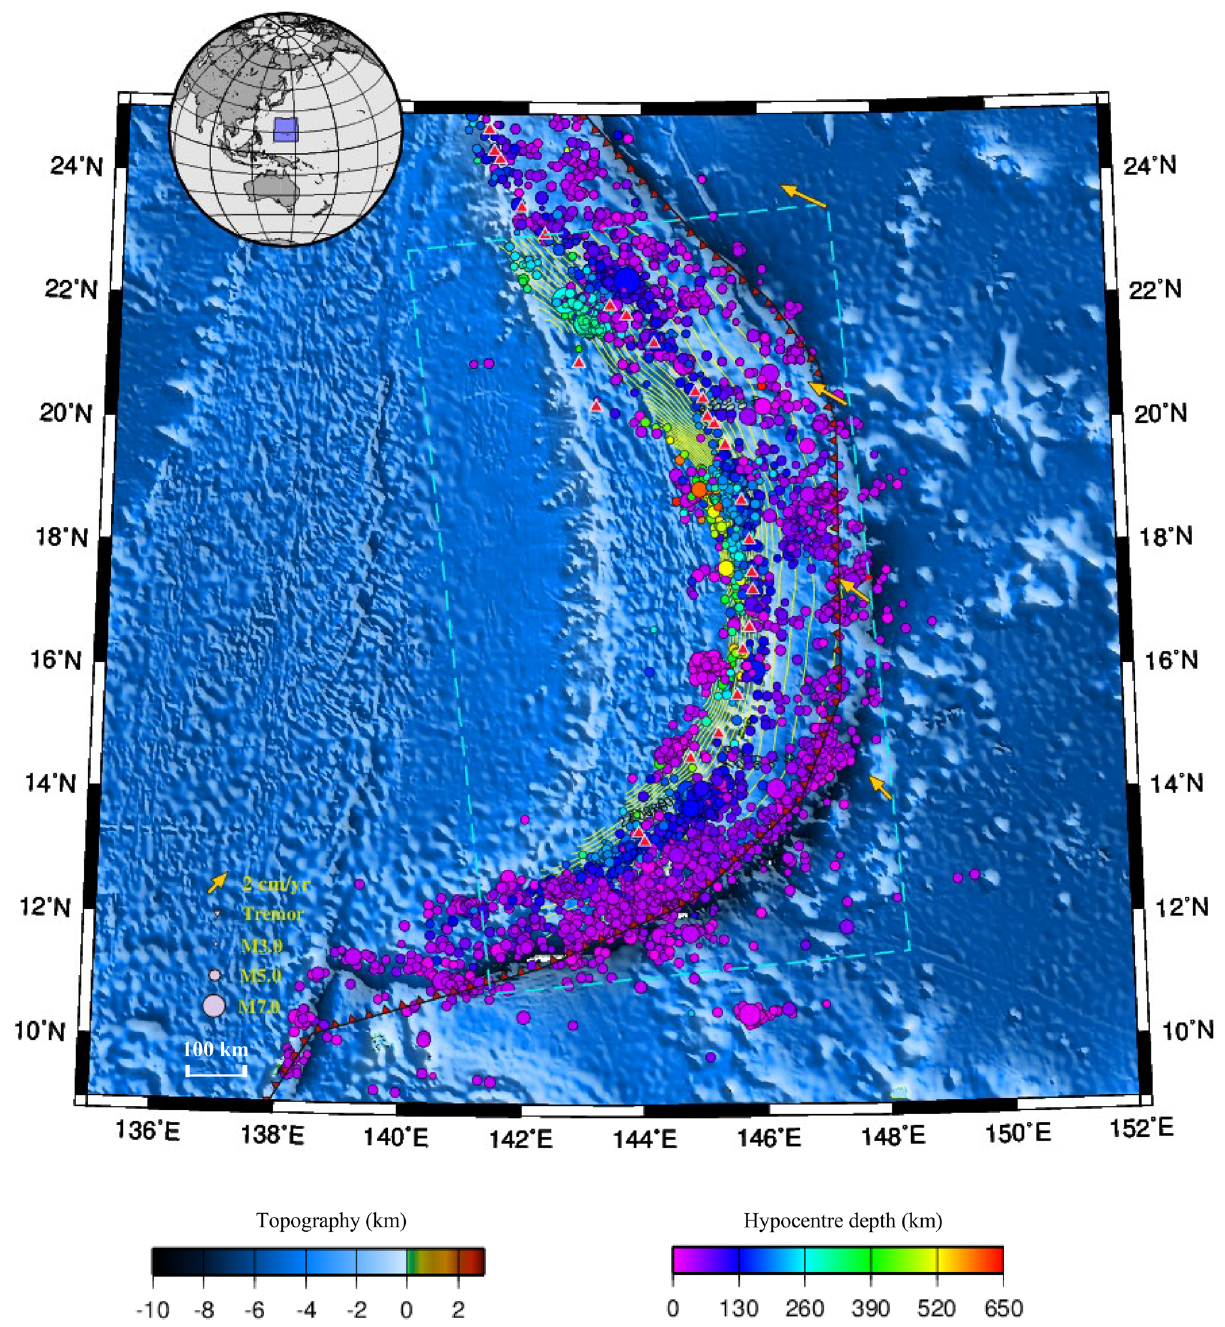
Figure 1. Tectonic map of the Marianas. Background colors indicate the surface topography (ETOPO 19 ). Green curved lines indicate the isodepth contours on the upper surface of the Pacific plate with an interval of 20 km (Slab2 20 ). Dashed light blue lines show the model region for the subducted Pacific Plate. Red triangles indicate active volcanoes 21 . The black curve with red barbs marks the convergent plate boundary 22 . Colored spheres indicate regular interplate earthquakes that occurred from January 1, 2001, to December 31, 2009 (IRIS 23 ). Yellow arrows indicate the motion of the Pacific Plate toward the Philippine Sea Plate (MORVEL 24,25 ). The map was created by using the Generic Mapping Tools (GMT) 26 (version: GMT 4.5.7, URL link: https:// www. gener ic- mappi ng- tools. org/ downl